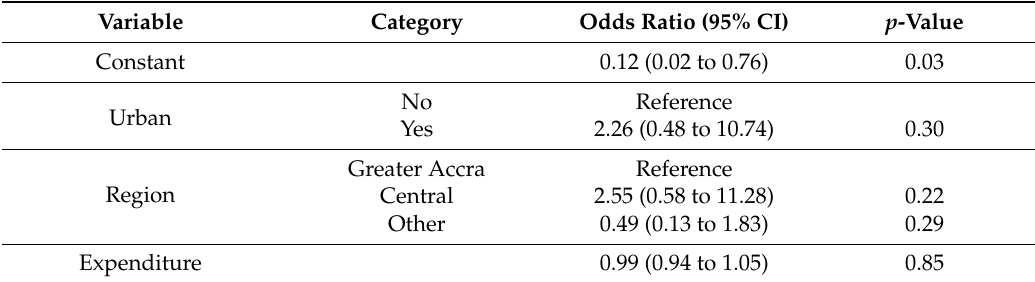
Table 4. Multivariable logistic regression results for detectable E. coli in 100 mL samples of sachet water (samples obtained directly from the source; n = 132).